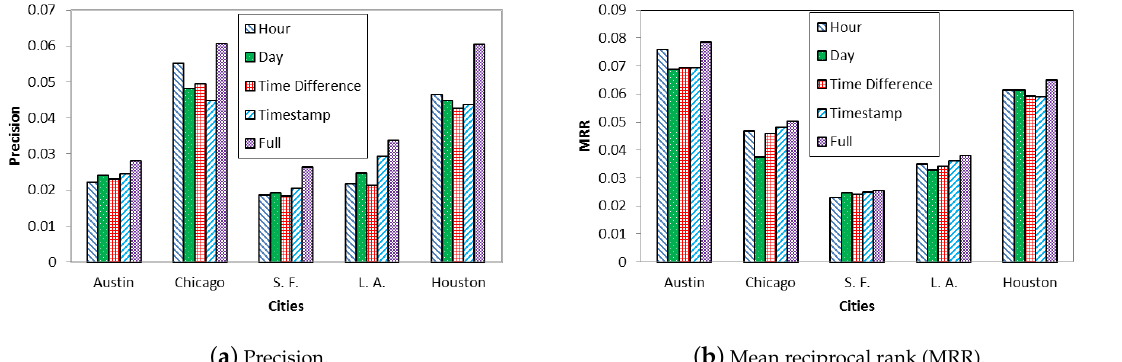
Figure 5. Temporal